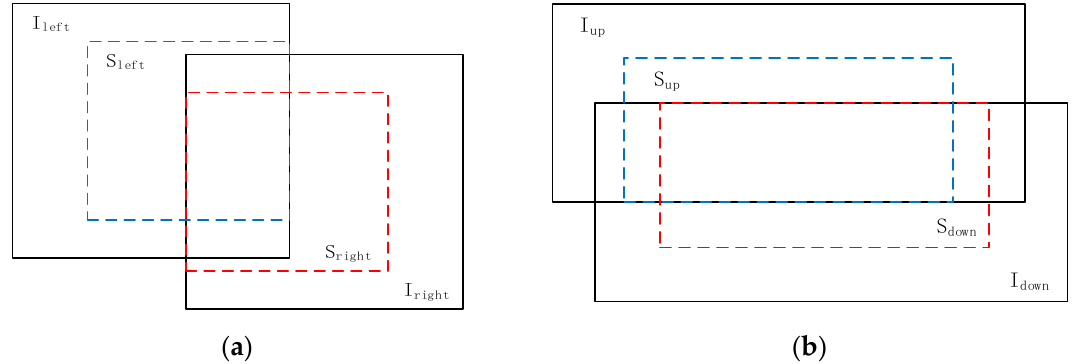
Figure 5. Two-power sub-images (the blue and red line represent the boundaries of 2-power sub-images): ( a ) the left-right overlap 2-power sub-images; ( b ) the up-down overlap 2-power sub-images.